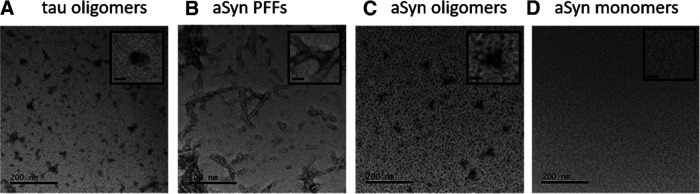
Structural analysis of α-syn samples. Electron micrographs of negative-stain-TEM transmission electron microscopy analyzed protein samples. The sample (5 μl) was applied onto a copper grid and fixed with uranyl acetate. Magnification is 60,000×. A, Tau aggregates (for reference) showing aggregated form. Inset, Higher magnification showing annular form of aggregates. B, α-Syn monomers show no aggregation. Inset, Higher magnification showing no structural form. C, α-Syn aggregates display many large fibrils (PFFs). Inset, Example of fibrils at higher magnification. D, α-Syn fibrils were added to intracellular patch solution and then sonicated for 15 min to form small aggregates. Inset, Annular form of aggregates. Scale bar: 200 nm, 20 nm .